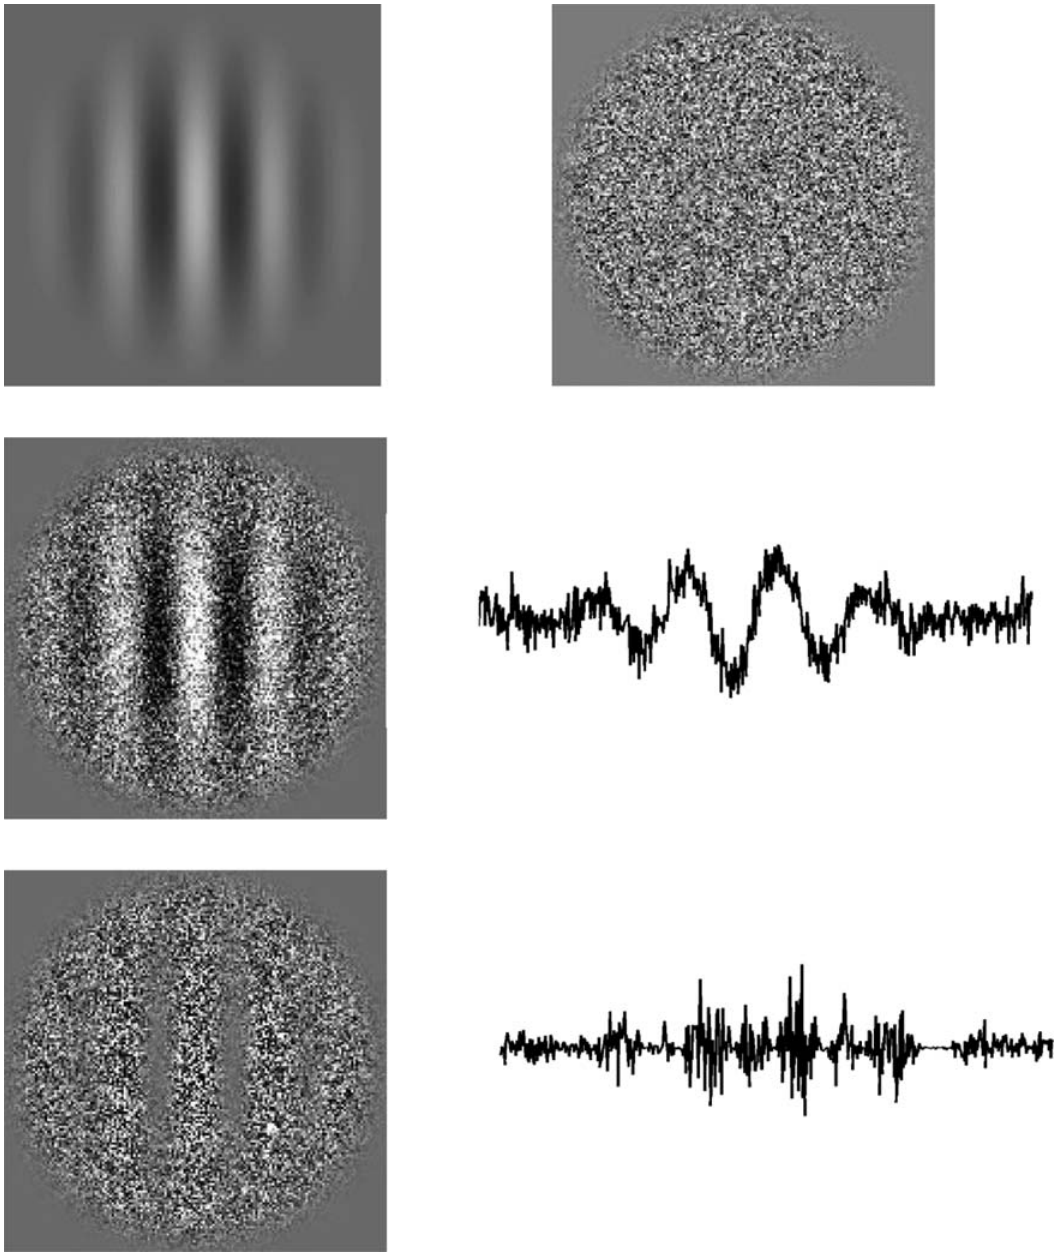
Figure 11. Visual stimuli representation. (Top row) Gabor patch signal (left), and carrier consisting of Gaussian noise (right). (Middle row) the spatial representation for luminance modulated (first order) stimuli. (Bottom row) the spatial representation for contrast modulated (second order) stimuli.